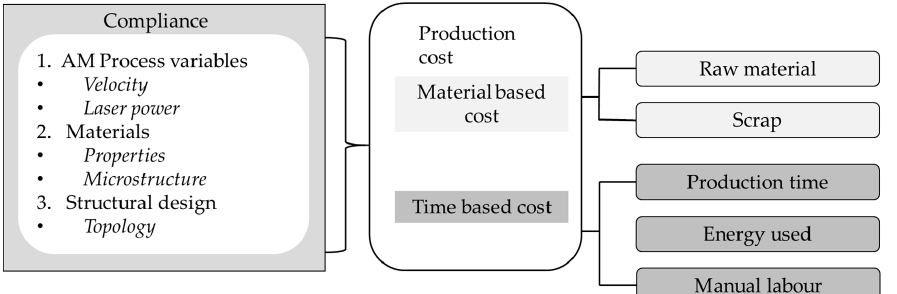
Figure 4. Schematic of concurrent method to reduce cost in metal additive manufacturing